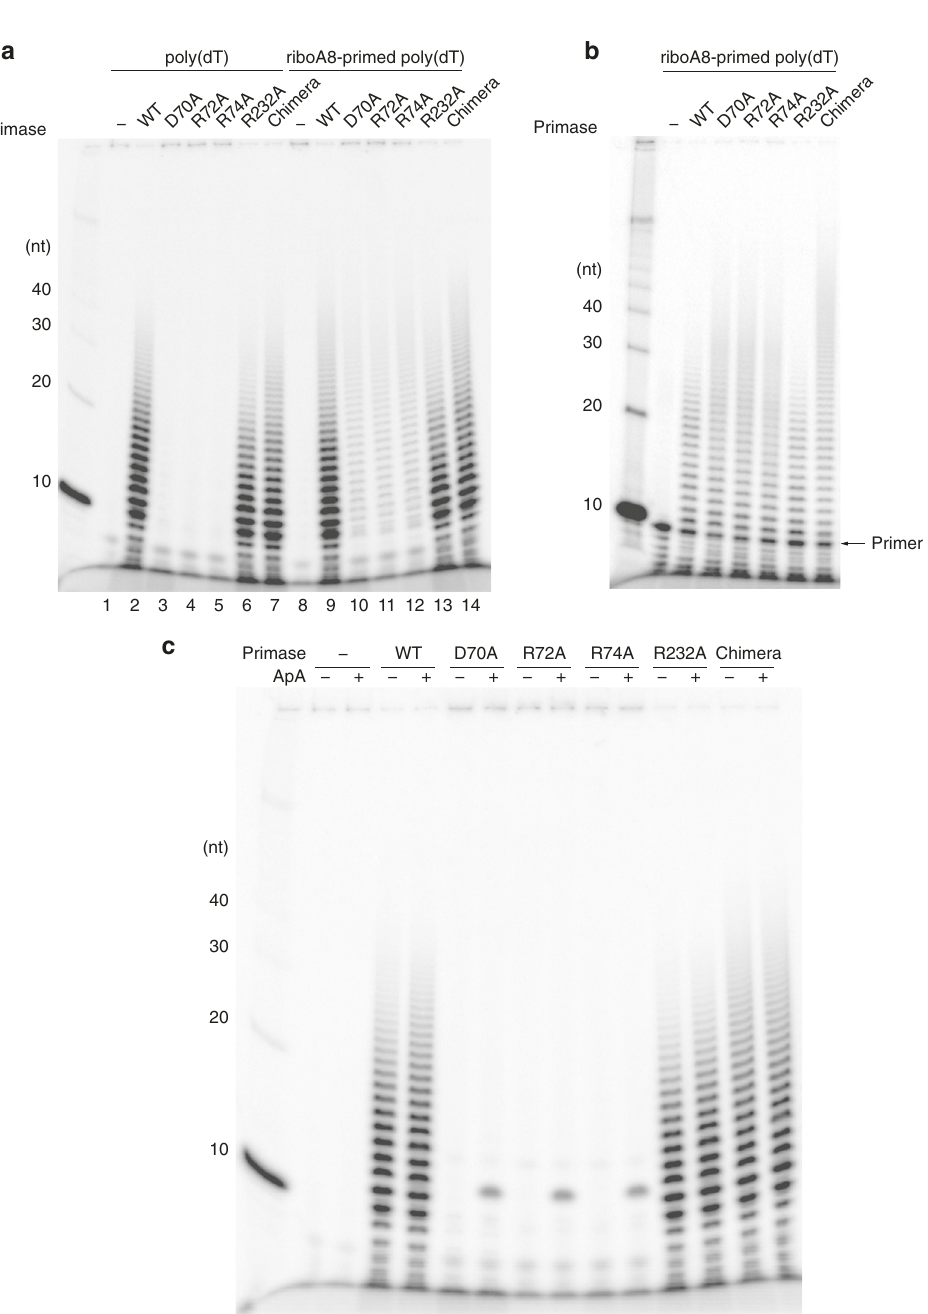
Fig. 6 The PriX mutants are defective in primer initiation but competent in primer elongation. All the reactions contain 500 nM primase. a Primer synthesis assay for wild-type, chimera and mutant primase, in the presence of either poly(dT) ssDNA template (lanes 2 – 7) or poly(dT) ssDNA template and ribo (A 8 ) primer (lanes 9 – 14). The reaction products were separated by PAGE under denaturing conditions and detected by phosphorimaging of the incorporated 32 P- α ATP. b Primer extension assay for wild-type, chimera and mutant primase, in the presence of a poly(dT) ssDNA template and 5 ′ -labeled 32 P-ribo(A 8 ) primer. The reaction products were separated by PAGE under denaturing conditions and detected by phosphorimaging. c Primer synthesis assay for wild-type, chimera and mutant primase, in the presence of a poly(dT) ssDNA template and ApA di-nucleotide. The reaction products were separated by PAGE under denaturing conditions and detected by phosphorimaging of the incorporated 32 P- α ATP. Note that short oligo-ribonucleotides have been demonstrated to have aberrantly slow mobility on denaturing polyacrylamide gels